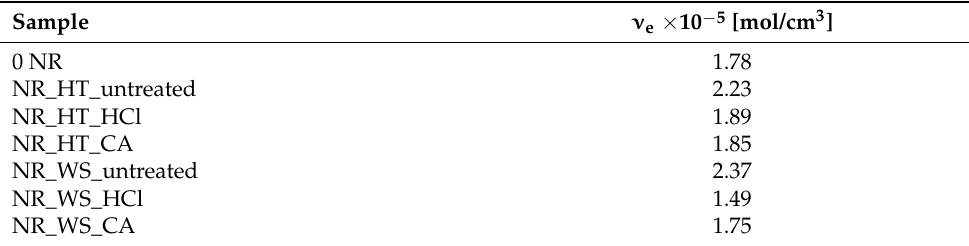
Table 5. Vulcanizates cross-linking